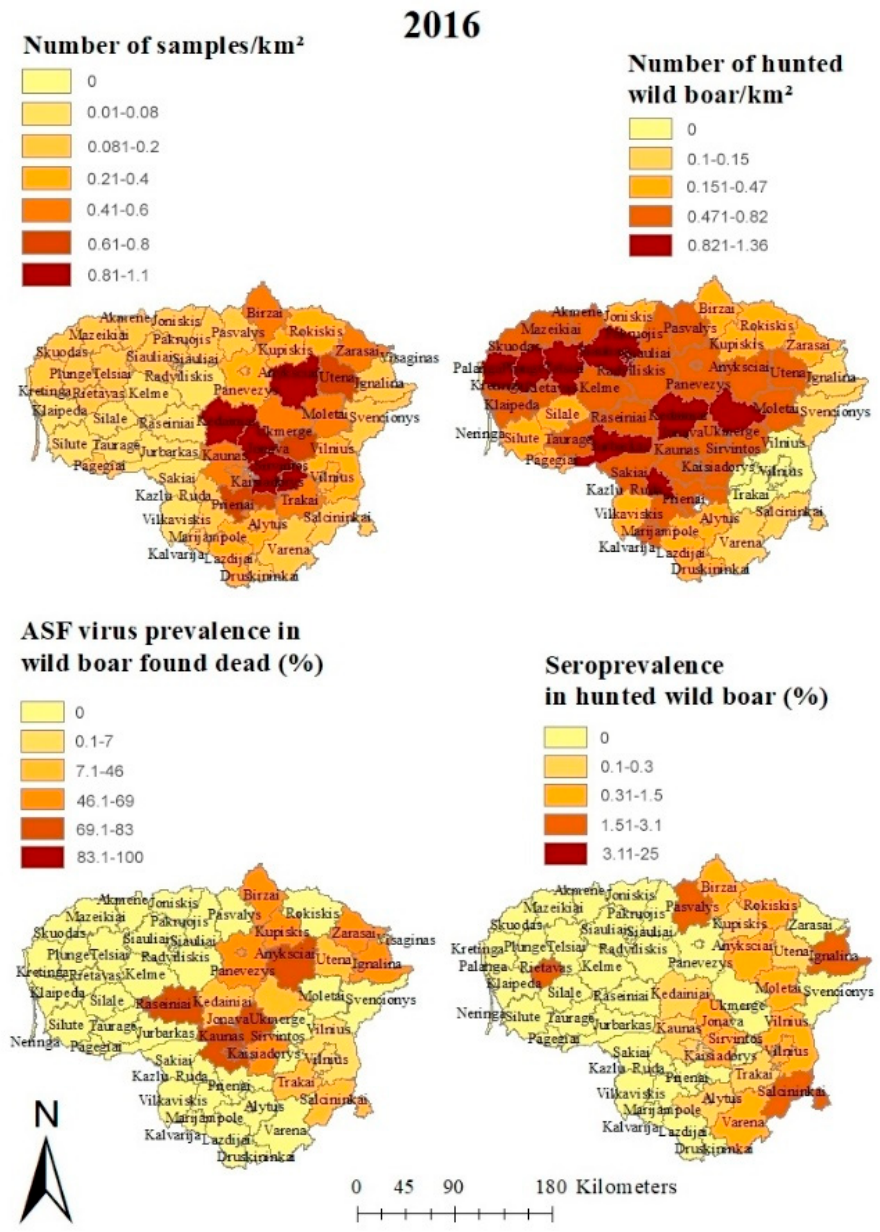
Figure 2. Numbers of investigated ASF samples and hunted wild boar, ASF virus prevalence estimates from wild boar found dead and seroprevalence estimates for hunted wild boar per municipality in Lithuania in 2016.